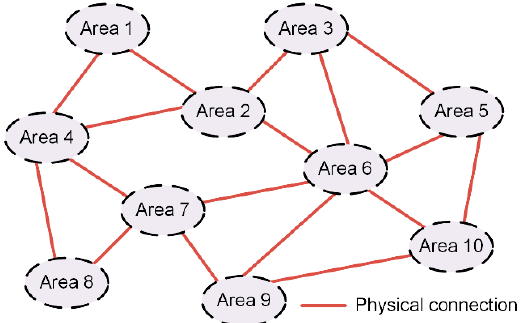
Figure 5. Physical connection of the multi − area power system.